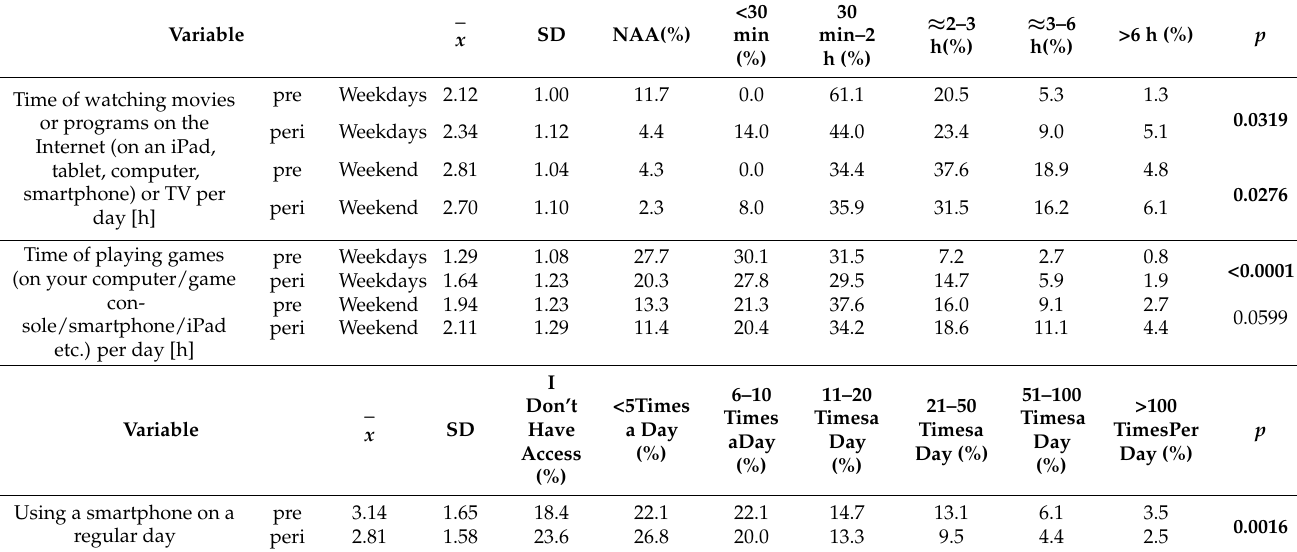
Table 2. The media usage characteristics in the groups pre- and peri COVID-19.